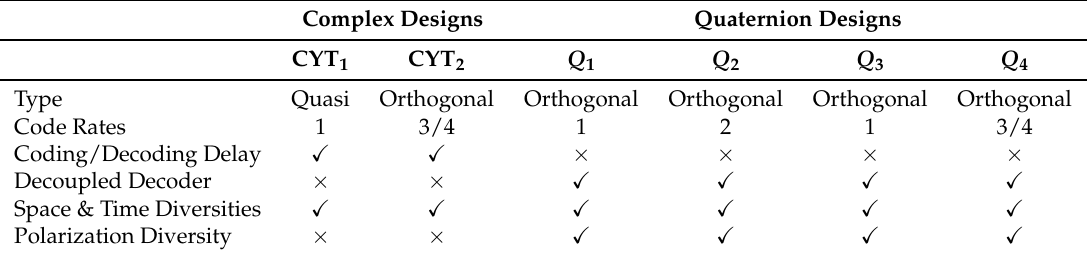
Table 2. Significant features of the quaternion domain and their comparison with their counter codes in complex domain.